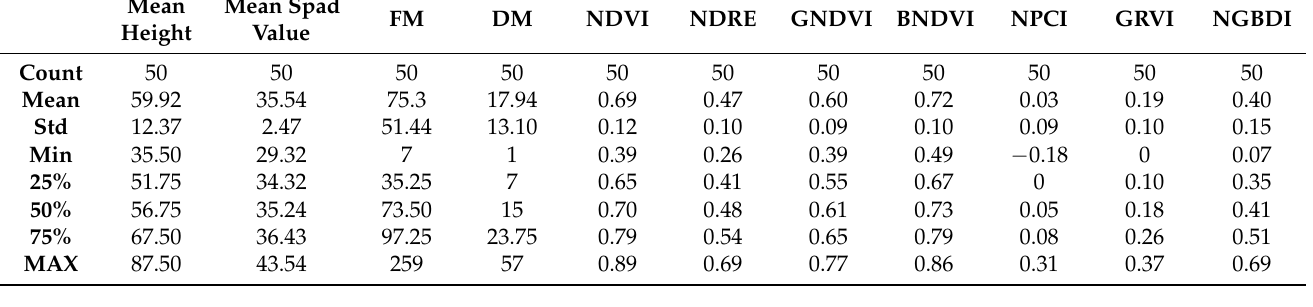
Table 5. EDA built with GTD and satellite remote sensing.